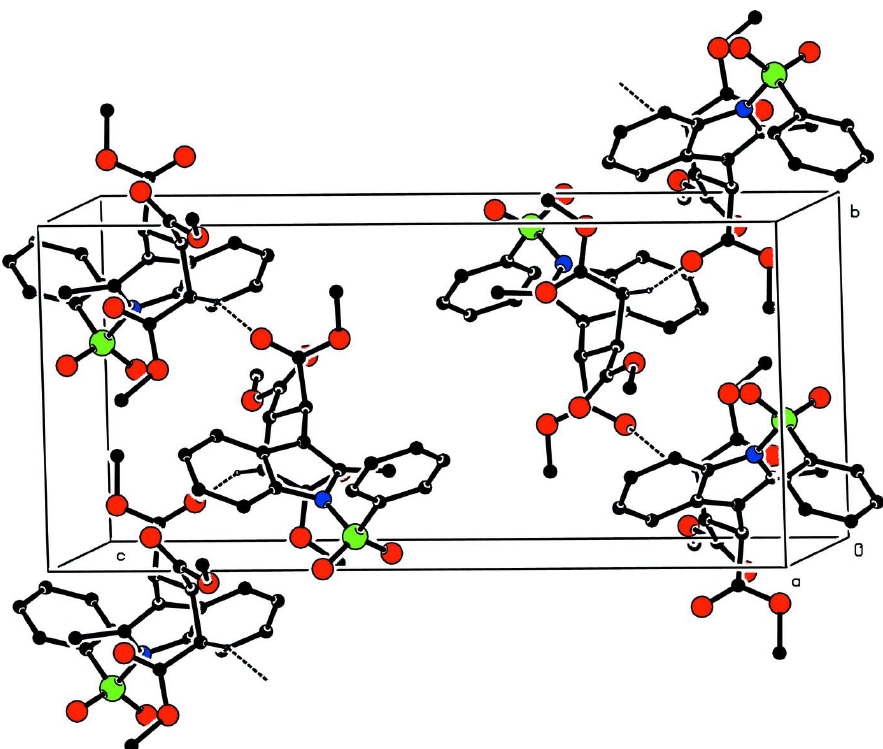
Figure 2 The molecular packing of the compound viewed down the b axis is shown. Dashed lines indicate hydrogen bonds. H atoms not involved in hydrogen bonding have been